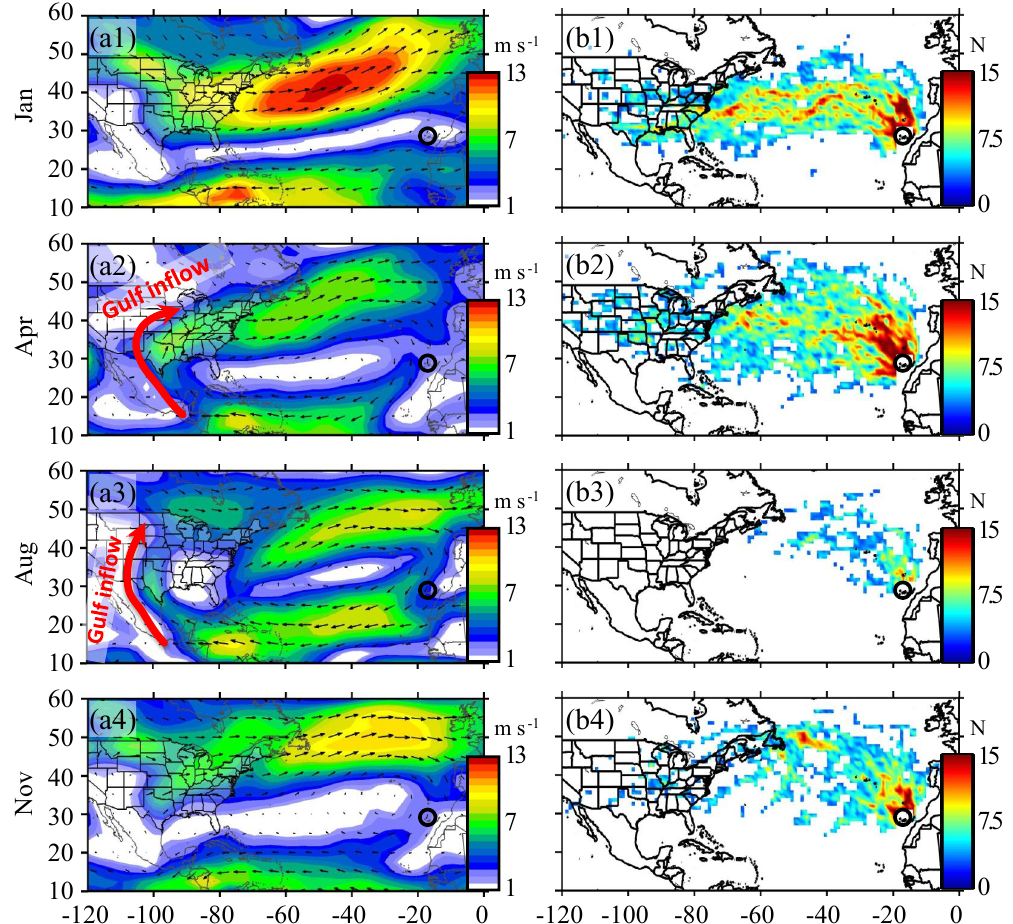
Figure 2. (a) Wind vector at 850mb and (b) transport route frequency (TRF) for January (Jan), April (Apr), August (Aug) and November (Nov) of the period 2008–2013. The Gulf inflow is highlighted as well as the location of Izaña (black